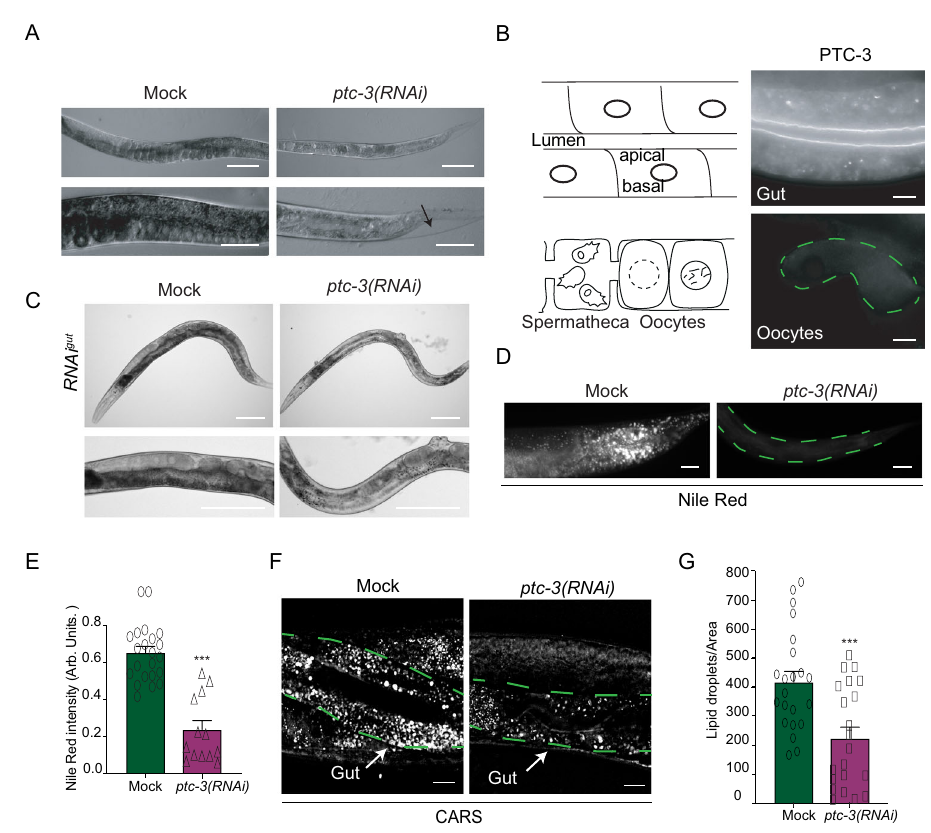
Fig. 1 Loss of PTC-3 causes developmental defects and loss of fat content. A Light microscopy images of adult N2 worms grown from L2 larva on mock or ptc-3(RNAi) bacteria. This feeding scheme was used for comparison between mock-treated and ptc-3(RNAi) adult animals. ptc-3(RNAi) animals are smaller, paler, and show cuticle defects. The arrow points to a cuticular defect. Scale bars upper panel 20 µ m, lower panels 100 µ m. n = 25 (mock) and 26 ( ptc-3(RNAi )) animals from 3 independent experiments. B Immuno fl uorescence of isolated intestine and gonad from wild-type worms. Schematic representation of the intestine and the proximal gonad. PTC-3 is present at the intestinal apical membrane. n = 20 from 3 independent experiments. Scale bar 10 µ m. ( C ) PTC-3 has cell-autonomous and non-cell-autonomous functions. Light microscopy images of adult gut-speci fi c RNAi worms (RNAi gut ) grown from L1 larva on mock or ptc-3(RNAi) bacteria. ptc-3(RNAi gut ) animals show intestinal and vulval defects. Scale bars 100 µ m. n = 16 (mock) and 27 ( ptc-3(RNAi )) animals from three independent experiments. D Lipid content is reduced in ptc-3(RNAi) animals. Nile Red staining of adult mock and ptc-3 (RNAi) treated worms after L2 stage. Scale bars 20 µ m. E Quanti fi cation of Nile Red staining shown in ( D ). Mean and SEM error bars. *** p = 0.000003, n = 22 (mock) and 13 ( ptc-3(RNAi )) animals. One-way ANOVA including data on Fig. 3C. F CARS microscopy reveals reduction of lipid levels in live adult ptc-3(RNAi) after L2 stage fed animals. Scale bars 10 μ m. The intestine is outlined by green dashed lines. Arrows point to the intestine. G Quanti fi cation of CARS signal. Mean and SEM error bars. *** p = 0.000524. n = 22 (mock) and 21 ( ptc-3(RNAi )); one-way ANOVA. Statistical source data are available as source